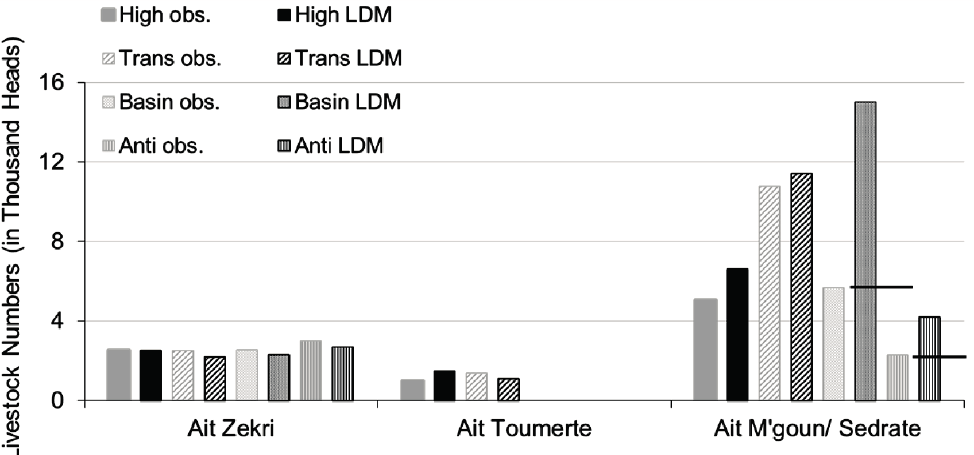
Figure 5. Calibration (Ait Zekri) and validation (Ait Toumerte and Ait M’goun/Sedrate) of livestock abundance showing observed and modeled values (land use decision model, LDM) for each region; High: Highland, Trans: Transition Zone, Basin: Basin of Ouarzazate, Anti: Anti Atlas; the horizontal lines indicate the manual reduction of fodder supply in rural